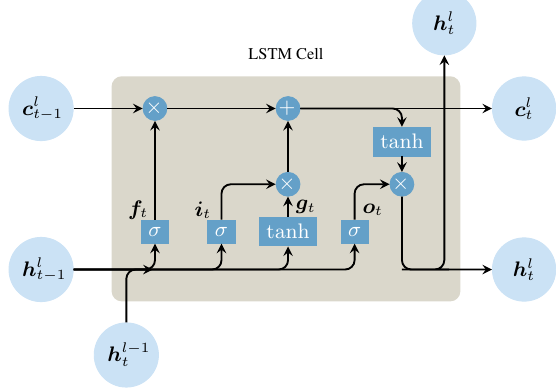
Figure 2. LSTM cells in layer l recieve information of previous 1 by means of two vectors: The observations at time step t − hidden layer h l t 1 represents the output information at previous − time and provides short-term memory , similar to RNN cells. The long-term information. Based on the cell state vector c l t 1 carries − forget gate f t , information in c t is discarded, input i t und modulation g t gates write new information to c t . The updated cell state c t and the output gate o t evaluate the hidden output layer h l t . (Figure adapted from